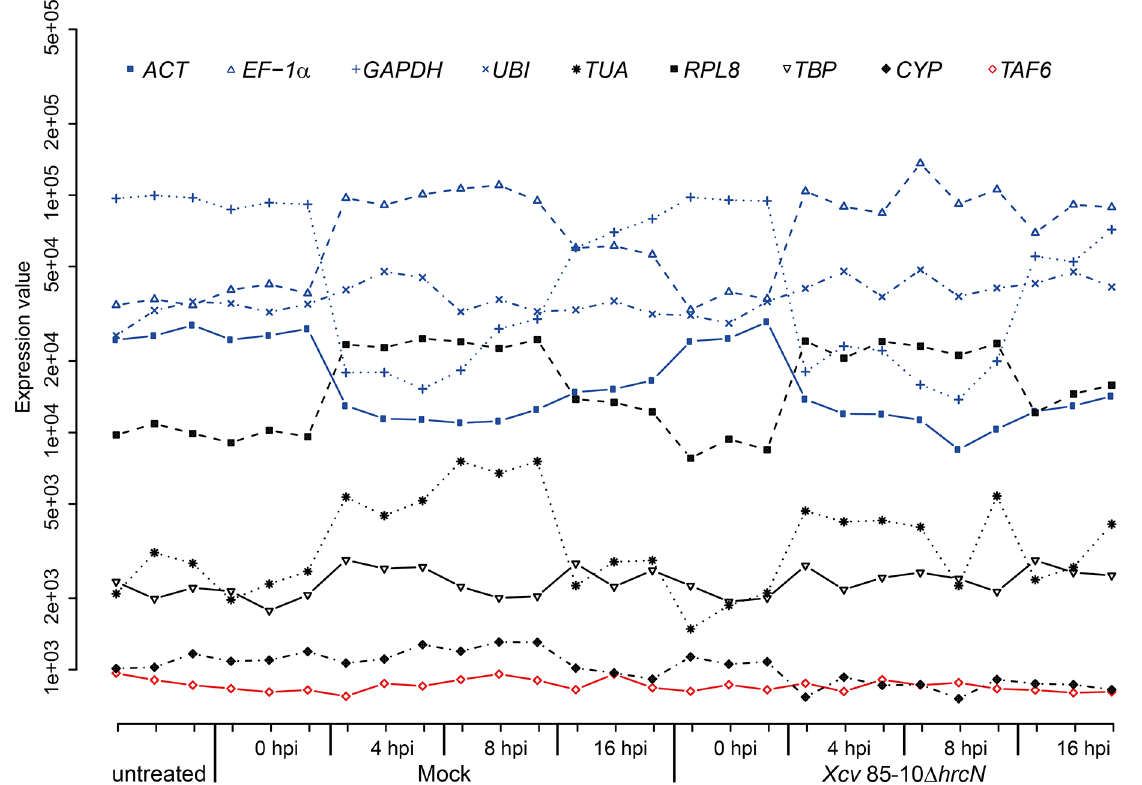
Fig 1. Expression pattern of traditional reference genes in healthy and Xcv -infected tomato plants. Leaves of S . lycopersicum cv. MM plants were untreated or infiltrated with 10 mM MgCl 2 (mock) and 85 – 10 Δ hrcN , respectively. To analyze mRNA accumulation of selected genes leaf material was harvested at 0, 4, 8 and 16 hours post infiltration (hpi). Relative RNA levels of housekeeping genes traditionally employed as references [30, 61 – 64] were determined by microarray hybridization analysis. Expression values of analyzed plant samples are plotted separately, i.e., three biological replicates per time-point per infiltration. For each gene, expression values were obtained as the mean of the intensities of all probes representing the respective gene. Blue curves represent housekeeping genes that were also analyzed in this study together with novel reference genes. In addition, the most stably expressed gene in the microarray experiment is shown (red curve). ACT ( actin ), TC194780a; EF-1 α ( elongation factor 1 α ), SGN-U212845; GAPDH ( glyceraldehyde 3-phosphate dehydrogenase ), TC198136a; UBI ( ubiquitin ), TC193502a; TBP ( TATA binding protein ), SGN-U329249; RPL8 ( ribosomal protein L8 ), X64562; TUA ( α -tubulin ), AC122540; CYP ( cyclophilin ), AK326854; TAF6 ( TFIID subunit 6 ),